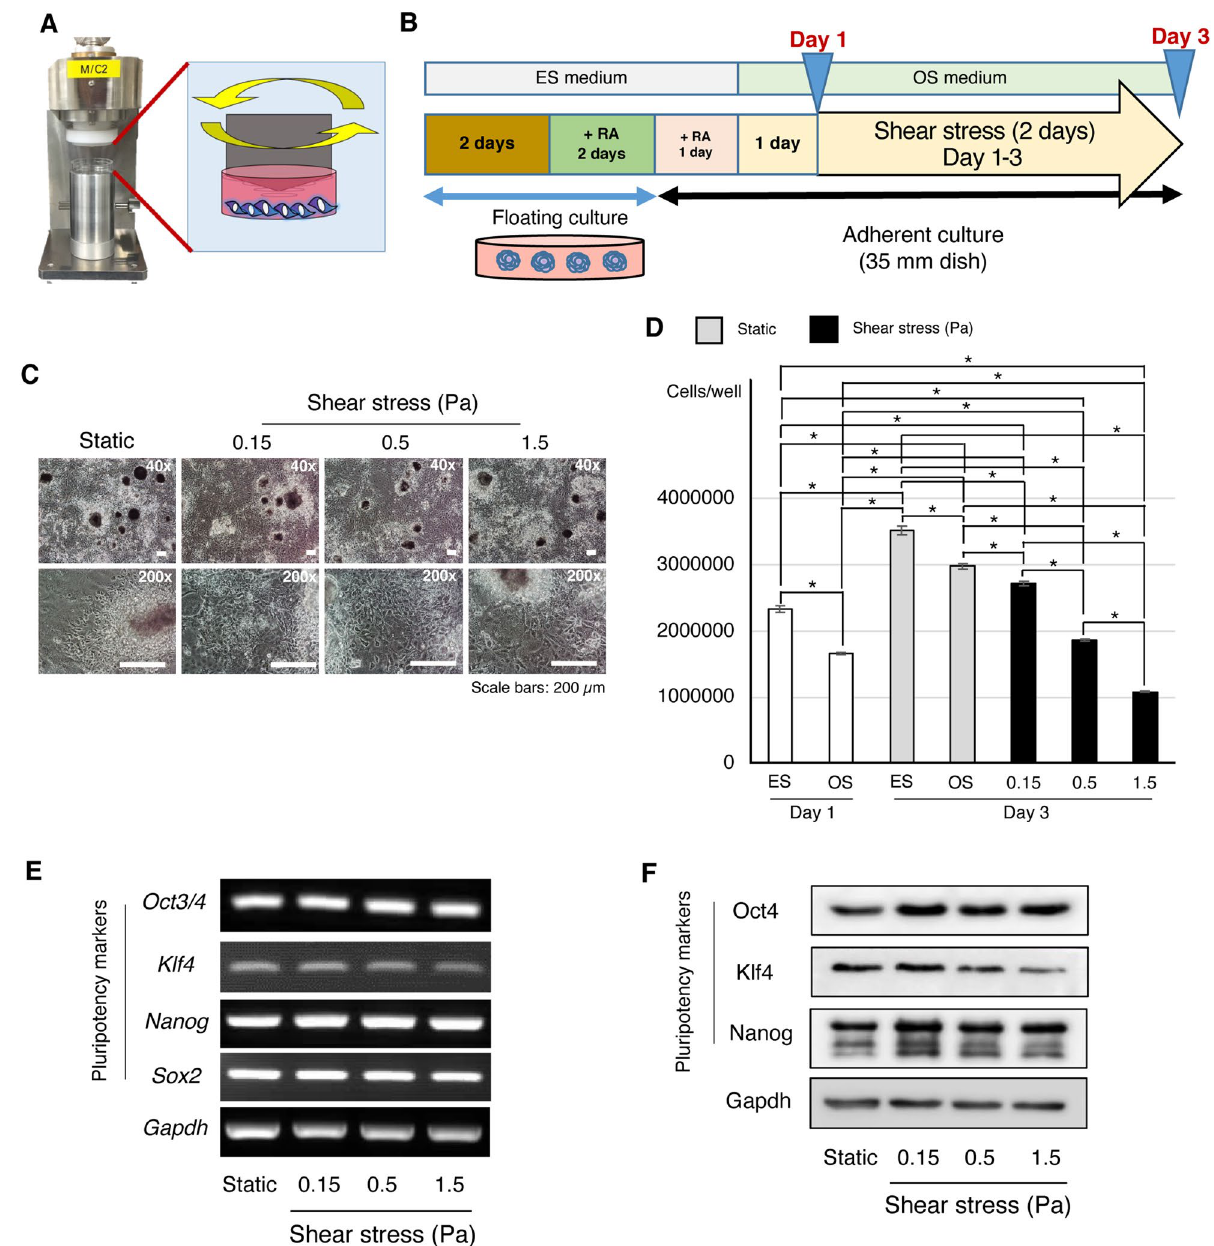
Figure 1. Continuous shear stress influenced the proliferation and pluripotency of iPSCs. ( A ) A novel shear stress loading apparatus was used in this study. ( B ) Osteogenic induction method. In brief, the embryoid bodies (EBs) were formed for two days and then maintained in iPSC growth (ES) medium supplemented with retinoic acid (RA), followed by adherent culture in osteogenic induction (OS) medium for one day prior to the application of shear force (0.15, 0.5, and 1.5 Pa) for 48 h. ( C ) Cell morphology and viability of static culture and shear loading (0.15, 0.5, and 1.5 Pa) on Day 3 of osteogenic induction were observed under a phrase-contrast microscope. The magnifications of upper and lower panels are 40× and 200×, respectively. Scale bars: 200 μm ( D ) WST-1 assay was performed to detect cell viability after shear force application (0.15, 0.5, and 1.5 Pa) for 48 h (Day 3). 3-day static culture in ES medium or OS medium was used as a control for cell viability. The cells in OS medium before applying shear stress (OS; Day 1) was used as a control to detect cell proliferation after applying shear stress for 48 h (Day 3). *: P < 0.05, ANOVA with Tukey’s multiple comparison test. Data represent the mean ± SD (n = 3). ( E ) Reverse transcription-polymerase chain reaction (RT-PCR) was performed to detect mRNA expression levels of pluripotency genes Oct3/4 , Klf4 , Nanog , and Sox2 . The expression of Gapdh was used as an internal control. Original gels are presented in Supplementary Fig. 4A. ( F ) Western blot analysis was performed to evaluate pluripotency protein markers Oct4, Klf4, and Nanog. Gapdh was used as a loading control. Original blots are presented in Supplementary Fig.